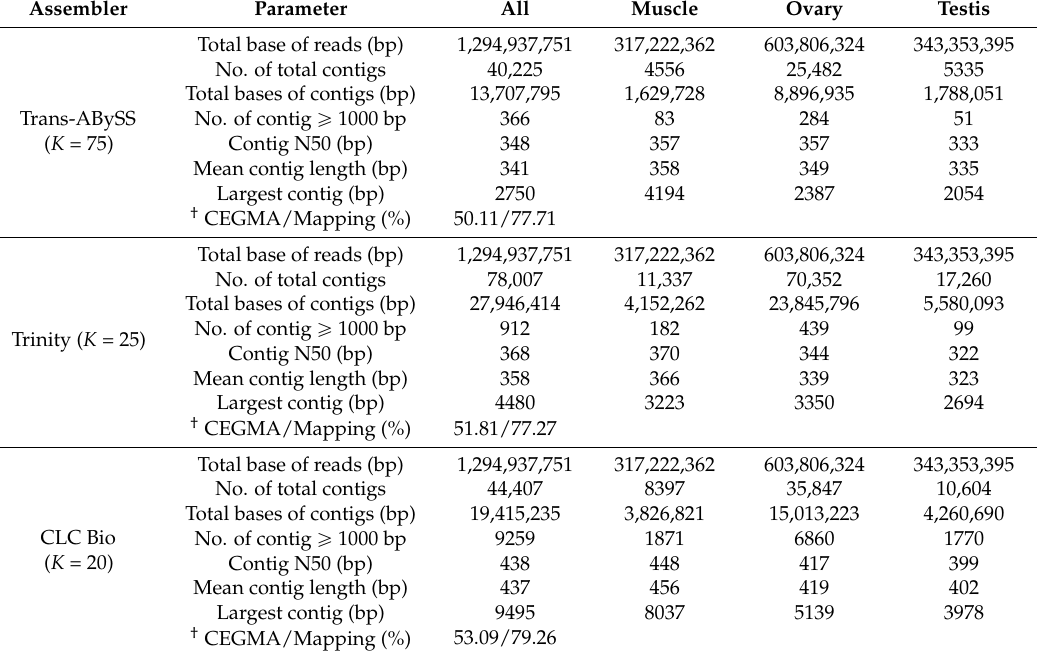
Table 2. Assembly results with best k -mer setting from the M . rosenbergii transcriptome 454 FLX and Ion-Torrent datasets using different de novo